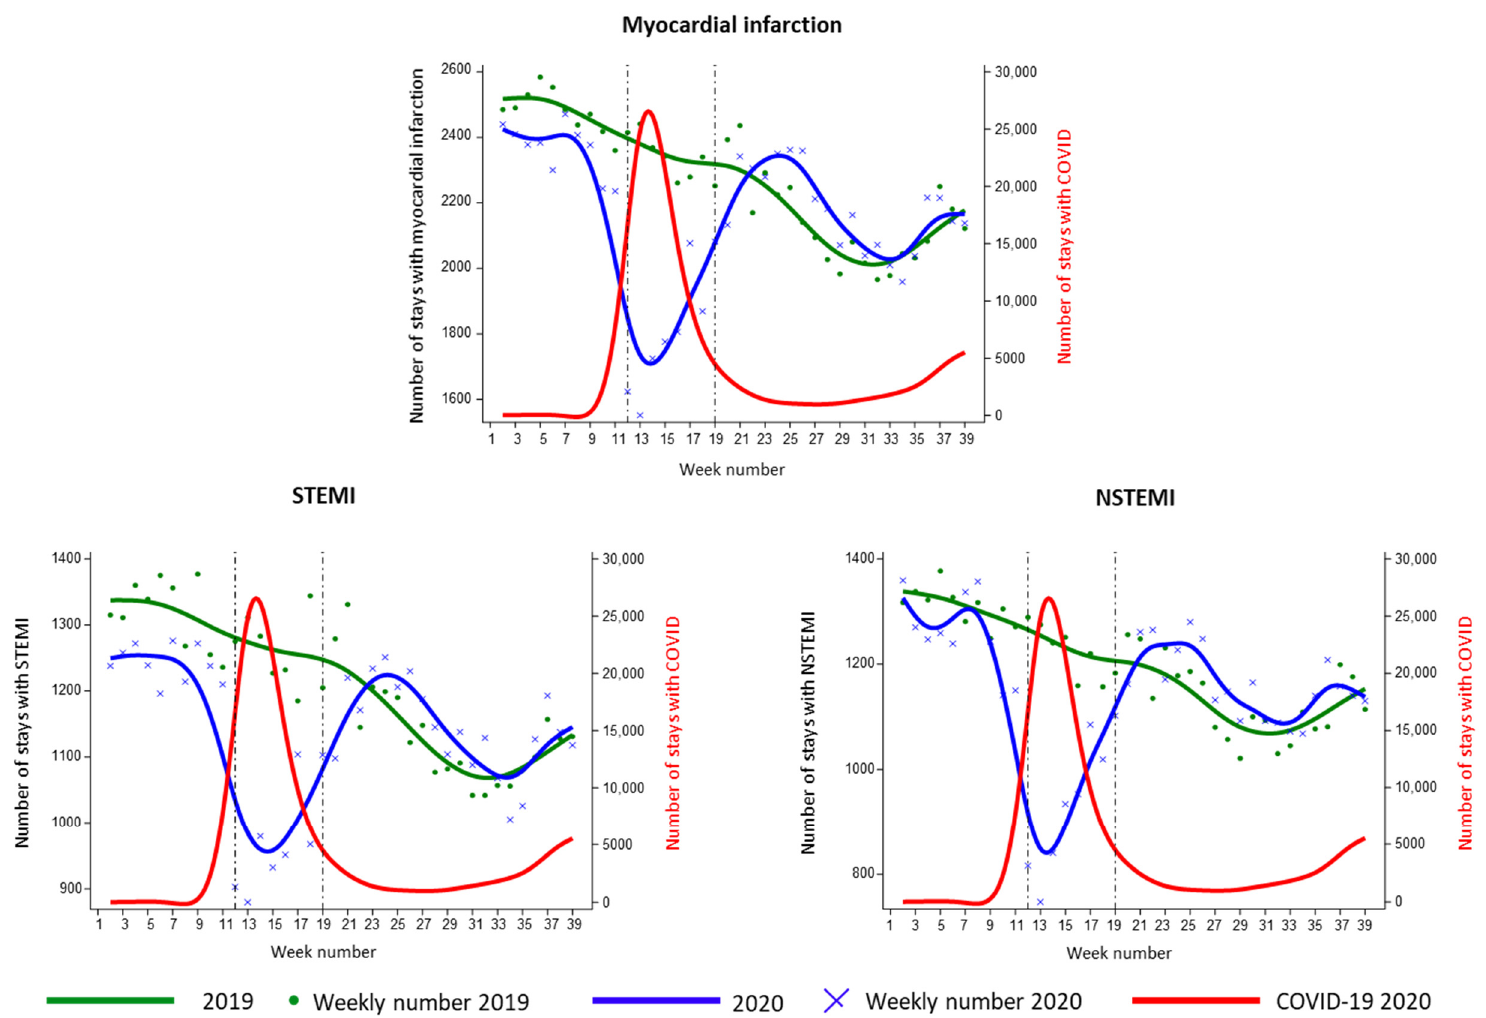
Figure 1. Hospital admissions for myocardial infarction and its subtypes in January to September 2020 versus 2019.